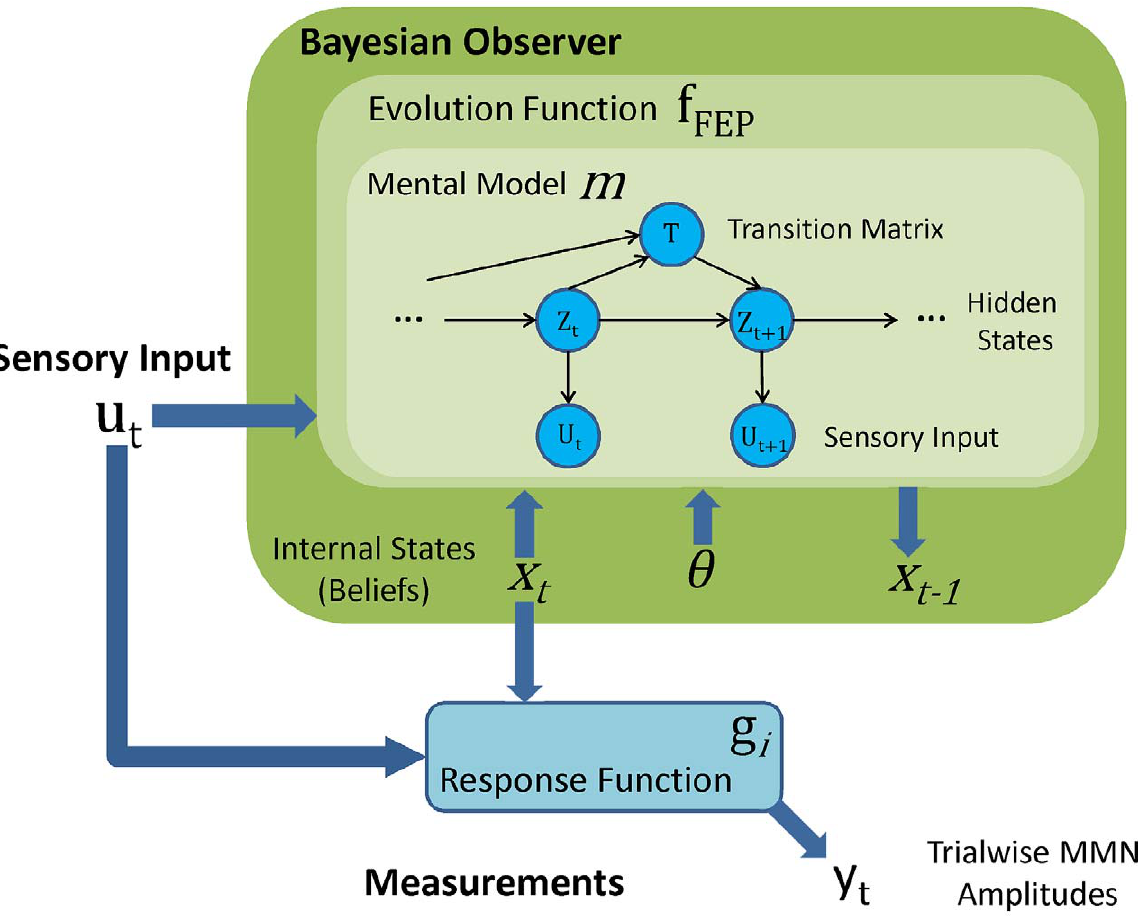
Figure 3. Structure of free-energy based models of the MMN. Our free-energy models of trial-wise MMN amplitudes ( fam FEP in Figure 2) are cast within the general dynamic state-space framework formulated in Equation (1). In contrast to the phenomenological models, the internal states ( x ) represent probabilistic beliefs about the environment and evolve according to approximate Bayesian inference by free-energy minimization ( f FEP ). All of these models share the Bayesian observer defined by the evolution function f FEP and the probabilistic mental model m , but differ in their response functions g . The graph in the innermost box shows the mental model m as a probabilistic graphical model (with arrows indicating conditional dependencies). The random variables in circles are sensory inputs ( U t ), tone categories ( Z t ), and transition probabilities ( T ). This mental model determines how subjects perceive, learn about and predict tone sequences. Please see Table 2 for an explanation of the mathematical notation.